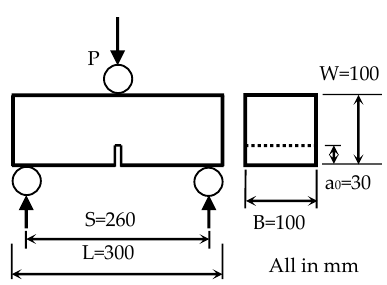
Figure 2. Configuration of three-point bending notched beam specimen.